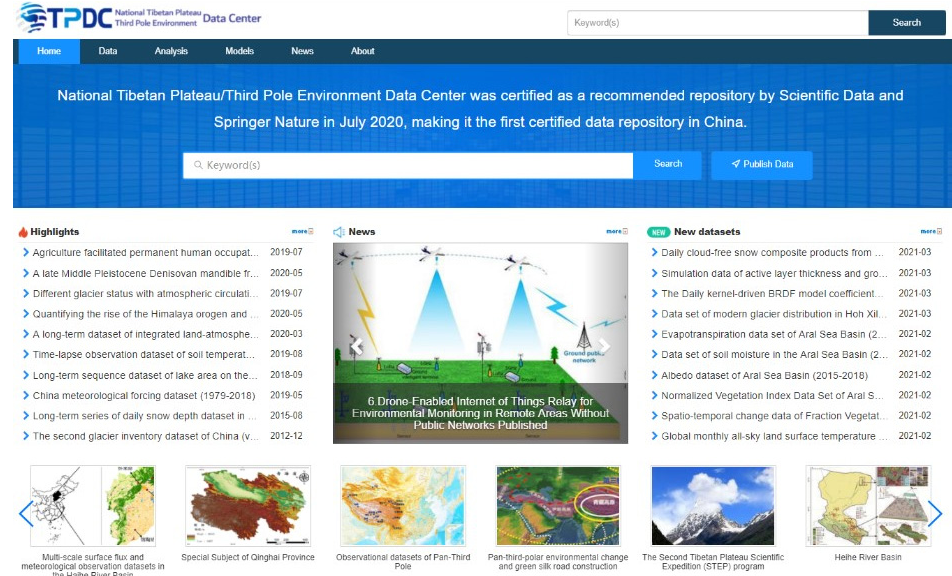
Figure 4. National Tibetan Plateau/Third Pole Environment Data Center.